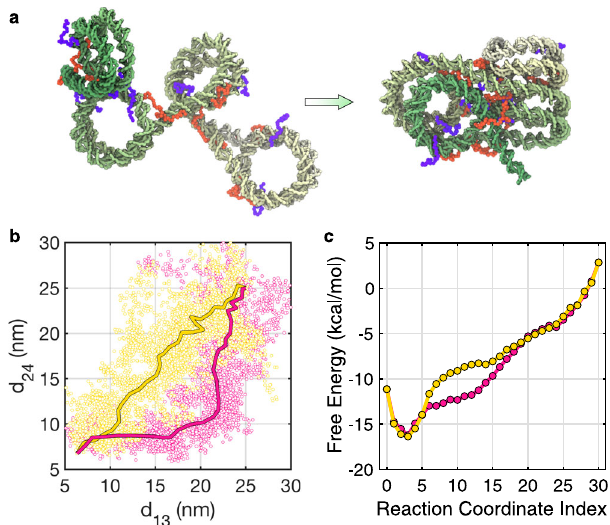
Fig. 4 Chromatin folding pathways determined using the fi nite temperature string method. a Illustration of the starting and end con fi gurations of the chromatin folding pathways using the same coloring scheme as in Fig. 2. b The sequential (pink) and concerted (yellow) pathways plotted over the two inter-nucleosome distances. The dots correspond to tetra-nucleosome con fi gurations obtained from individual simulations restricted to Voronoi cells de fi ned using images along the path. They represent fl uctuations around the path on the scale of k B T . c Free energy pro fi les along the two pathways. See Supplementary Fig. 6 for corresponding results of the second sequential